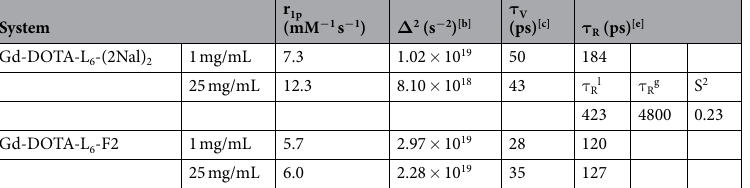
Table 2. Relaxometric parameters extracted from the fitting of NMRD profiles reported in Fig. 8 [a] . [a] On carrying out the fitting procedure, some parameters were fixed to reasonable values: r Gd-H (distance between Gd and protons of the inner sphere water molecule) = 3.1 Å; a (distance of minimum approach of solvent water molecules to Gd 3 + ion) = 3.8 Å; D (solvent diffusion coefficient) = 2.2∙10 − 5 cm 2 s − 1 . [b] Squared mean transient zero-field splitting (ZFS) energy. [c] Correlation time for the collision-related modulation of the ZFS Hamiltonian. [d] Electronic relaxation time at zero field (calculated as 1/ τ s0 = 12 Δ 2 × τ v ). [e] Reorientational correlation time.